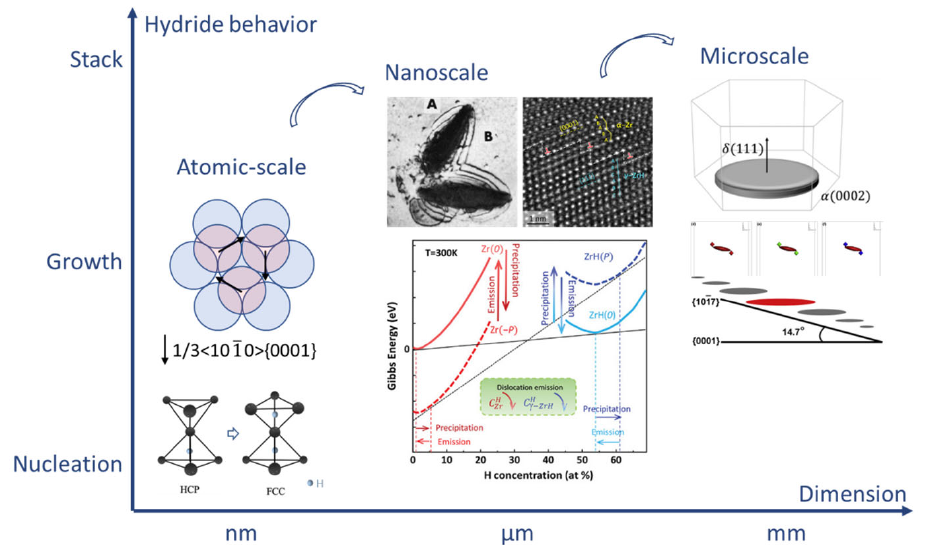
Figure 3. The mechanism of hydride behavior under di ff erent dimensions under stress-free